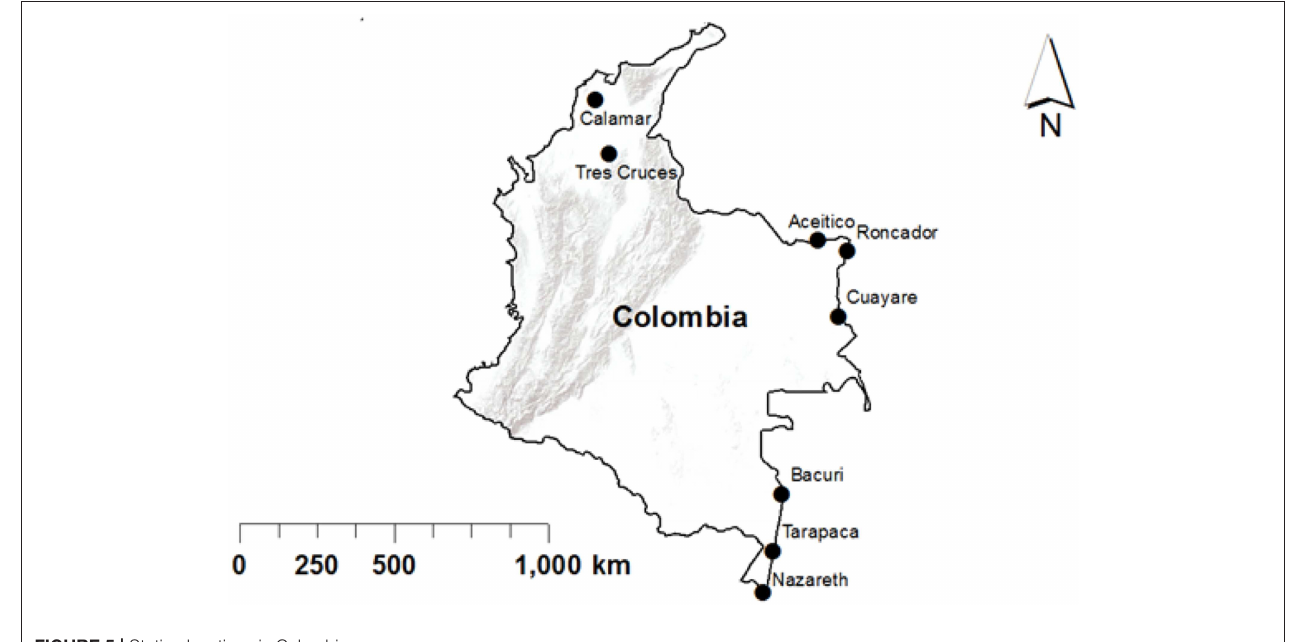
FIGURE 5 | Station locations in Colombia.